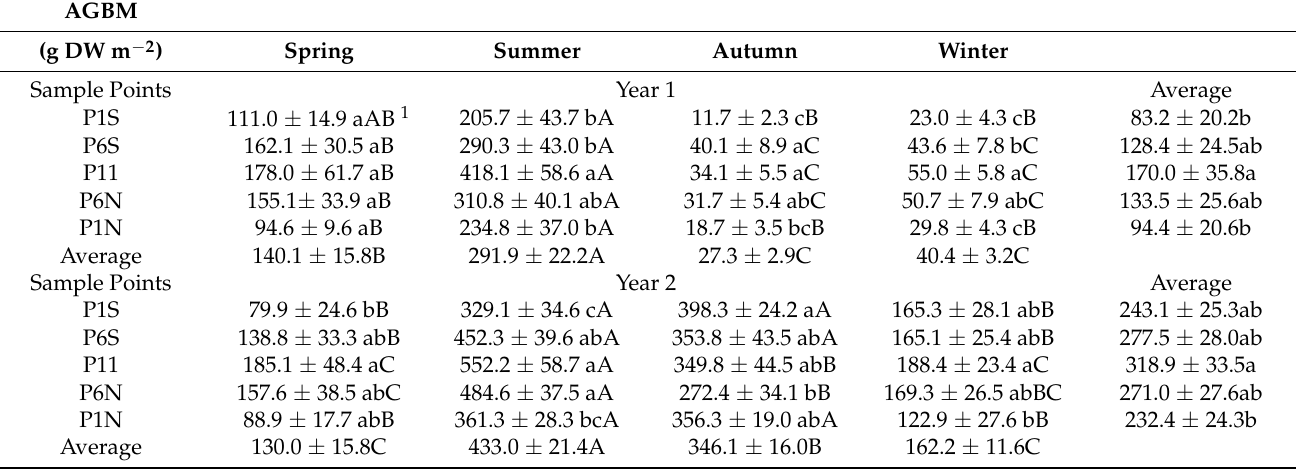
1 Means followed by different lowercase letters within the same column indicate differences between the sample points; different uppercase letters within the same row indicate differences between the seasons; both at 5%